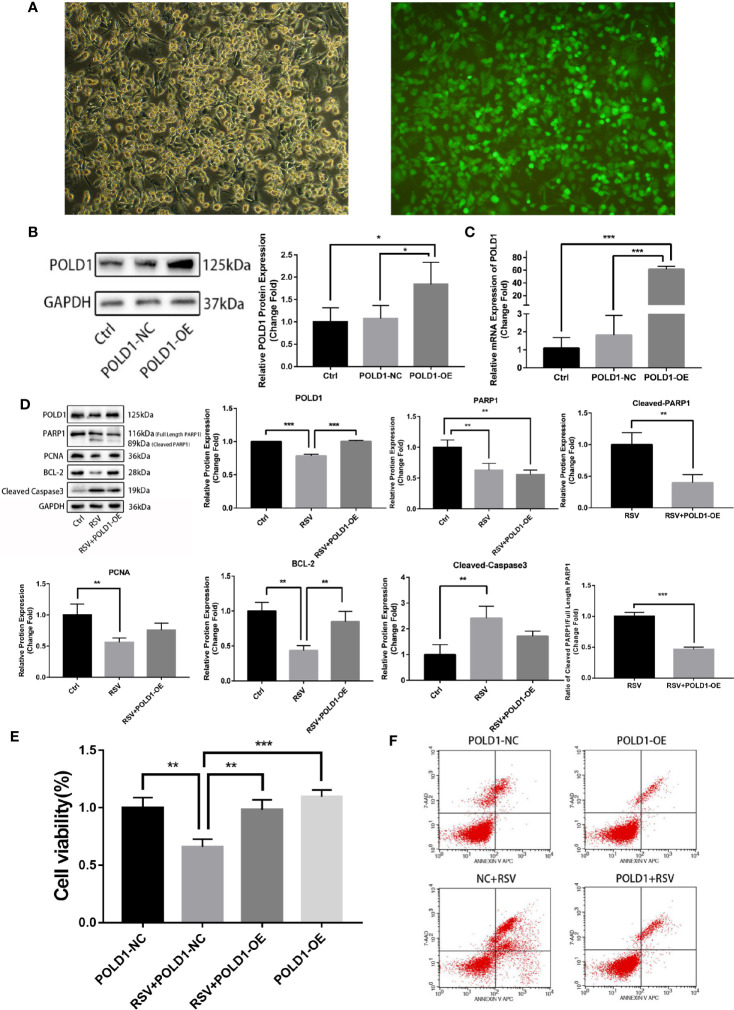
POLD1 rescue experiment (A) Immunofluorescence of POLD1 transfected with lentivirus. (B) POLD1 protein expression after transfection (control and POLD1-NC: *P=0.035, POLD1-NC and POLD1-OE: *P=0.048). (C) Gene expression of POLD1 after transfection (control and POLD1-NC: **P=0.007, POLD1-NC and POLD1-OE: **P=0.007). (D) Apoptosis indicators of breast cancer cells after transfection (POLD1:***P<0.001, PARP1: control and RSV+POLD1-OE: **P=0.004, RSV and RSV+POLD1-OE: **P=0.001, Cleaved PARP1/Full Length PARP1: ***P<0.001, PCNA: **P=0.004, BCL-2:control and RSV: **P=0.001, RSV and RSV+POLD1-OE: **P=0.006, Cleaved Caspased 3: **P=0.003),. (E) CCK8 detection of resveratrol treated breast cancer cell survival after transfection (**P=0.001, ***P<0.001). (F) Flow cytometry detection of resveratrol-treated apoptosis of breast cancer cells after transfection (on the two-parameter scatter diagram of flow cytometry, the lower left quadrant represents living cells; the upper left quadrant represents necrotic cells; the lower right quadrant represents apoptotic cells (late apoptotic cells), and the upper right quadrant represents early apoptotic cells).